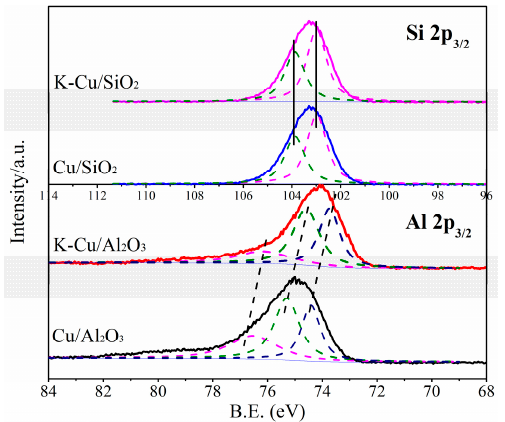
Figure 8. Al2p XPS spectra of Cu/Al 2 O 3 , K-Cu/Al 2 O 3 and Si 2p XPS spectra of Cu/SiO 2 , K-Cu/SiO 2 catalysts .